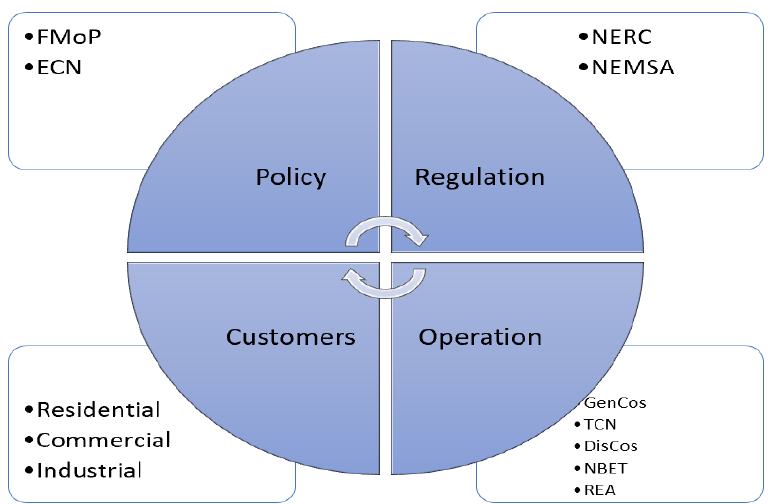
Figure 3. Nigeria Electricity Market Industry (FMoP: Federal Ministry of Power; ECN: Energy Com- mission of Nigeria; NERC: Nigeria Electricity Regulatory Commission; NEMSA: Nigeria Electricity Management Services Agency; GenCos: Generation Companies; TCN: Transmission Company of Nigeria; DisCos: Distribution Companies; NBET: Nigeria Bulk Electricity Trading Company Plc).